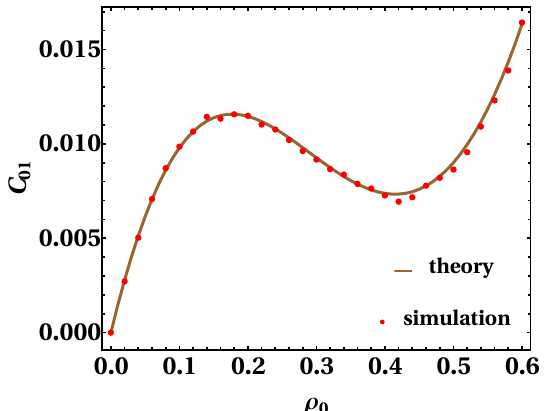
Figure 6: The figure illustrates the variation of two-point correlation C be- 01 tween the vacancy and species 1 by tuning the vacancy density ρ . We observe 0 that this correlation initially starts increasing with increasing ρ , reaches to a lo- 0 cal maximum, then decreases. However, as ρ is increased further, C reaches 0 01 to a local minimum and then starts increasing again. The parameters used are = 0.3, p = 1.0, ε = 0.1, w = 0.8, w = 1.0, ρ = 0.2. The ensem- L = 10 3 , p + 1 2 12 21 ble average is done over 10 5